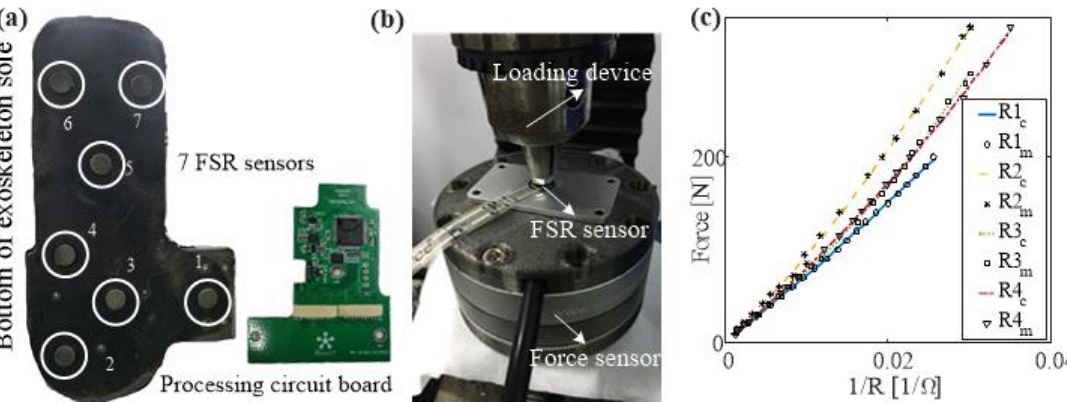
Figure 3. Calibration of accessory equipment. ( a ) Seven force-sensing resistor (FSR) sensors were mounted at the bottom of the exoskeleton sole to measure human-machine coupled ground reaction force (GRF). ( b ) Each FSR sensor was calibrated with a loading test bench by a force sensor (M4325K, Sun Rise Instrument, Inc., Nanning, China) with a range of 400 N and an accuracy of 0.5% FS. ( c ) Fitted results of calibration. Maximum RMS error of all calibration results was 3.601 N.